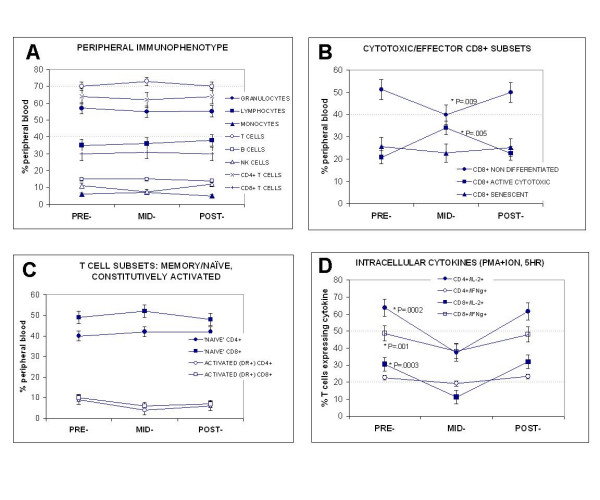
Mean peripheral blood percentages are plotted for (A) all major major leukocyte subsets; (B) cytotoxic, senescent and naïve (non-differentiated) CD8+ T cell subsets; and (C) memory (CD45RO+) and constitutively activated (HLA-DR+) CD4+ and CD8+ T cell subsets. (D) Mean percentages of T cell subsets capable of being stimulated to produce IFNg and IL-2. These data are derived from whole blood cultures stimulated with PMA+ionomycin for 5 hours in the presence of monensin to inhibit extracellular transport and allow intracellular accumulation. For all plots, mean values are shown without error bars. Data that were found to be statistically significant (pre-, vs. mid-) are indicated by '*' and the corresponding 'P' value. All other data were not statistically significant. Error bars represent the SEM for each point.